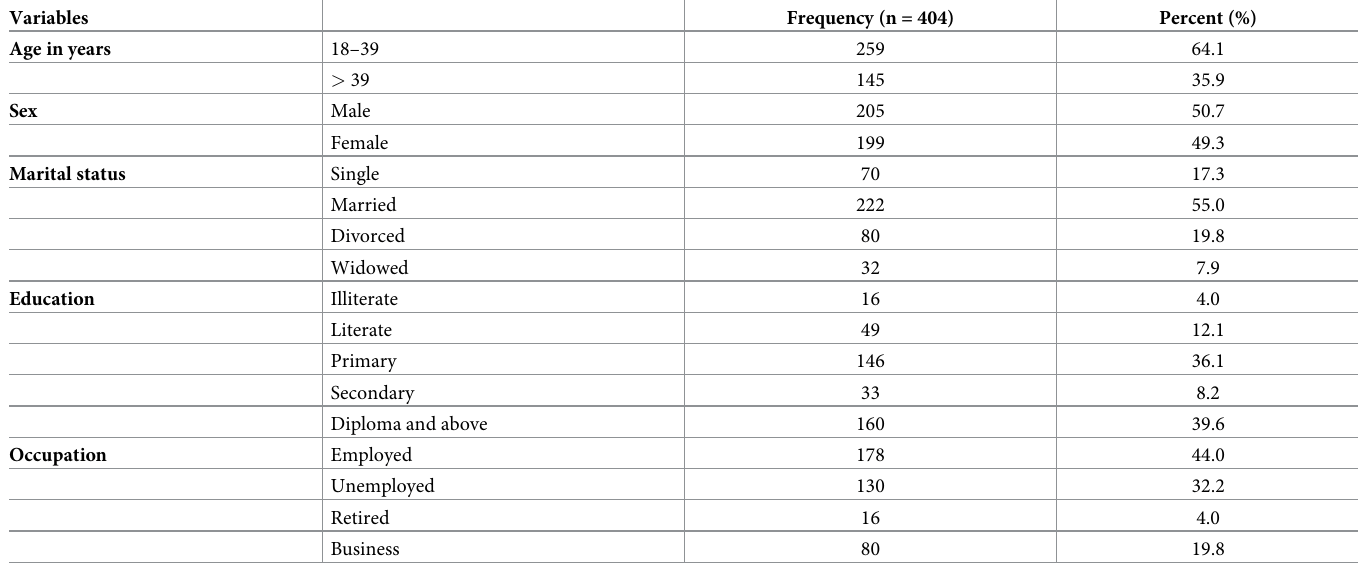
Table 1. Demographic characteristics of the respondents towards COVID-19 (n =